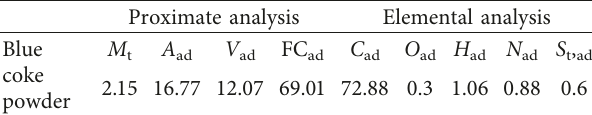
Table 1: Proximate and elemental analyses of blue coke powder. Proximate analysis Elemental analysis